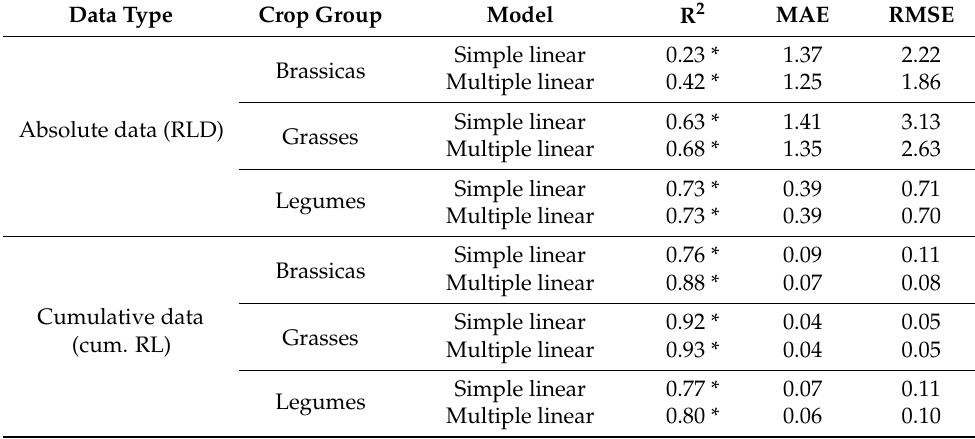
Table 4. Performance metrics of regression models in test dataset, by crop group and data type. RLD, root-length density and cum. RL, cumulative root-length. R 2 , coefficient of determination and * indicates that the correlation between predicted and measured RLD or cum. RL was significant, with a p -value < 0.05. MAE, mean absolute error, and RMSE, root mean absolute error. Data Type Crop Group Model R